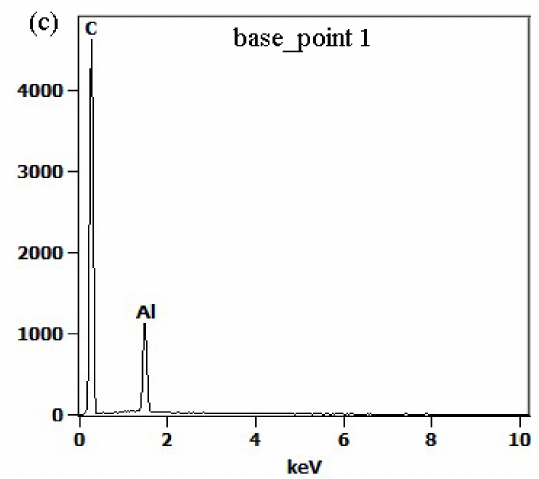
Figure 12. The Al 4 C 3 particles formed on the surface of pyrocarbon: ( a , c ) SEM and EDS patterns of the particles; and ( b ) the formation mechanism of Al 4 C 3